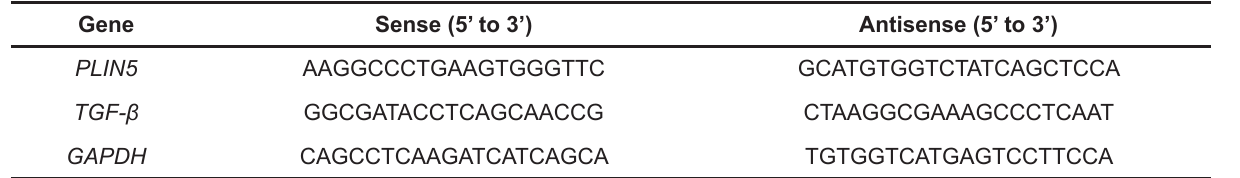
Table 1. Primers used for